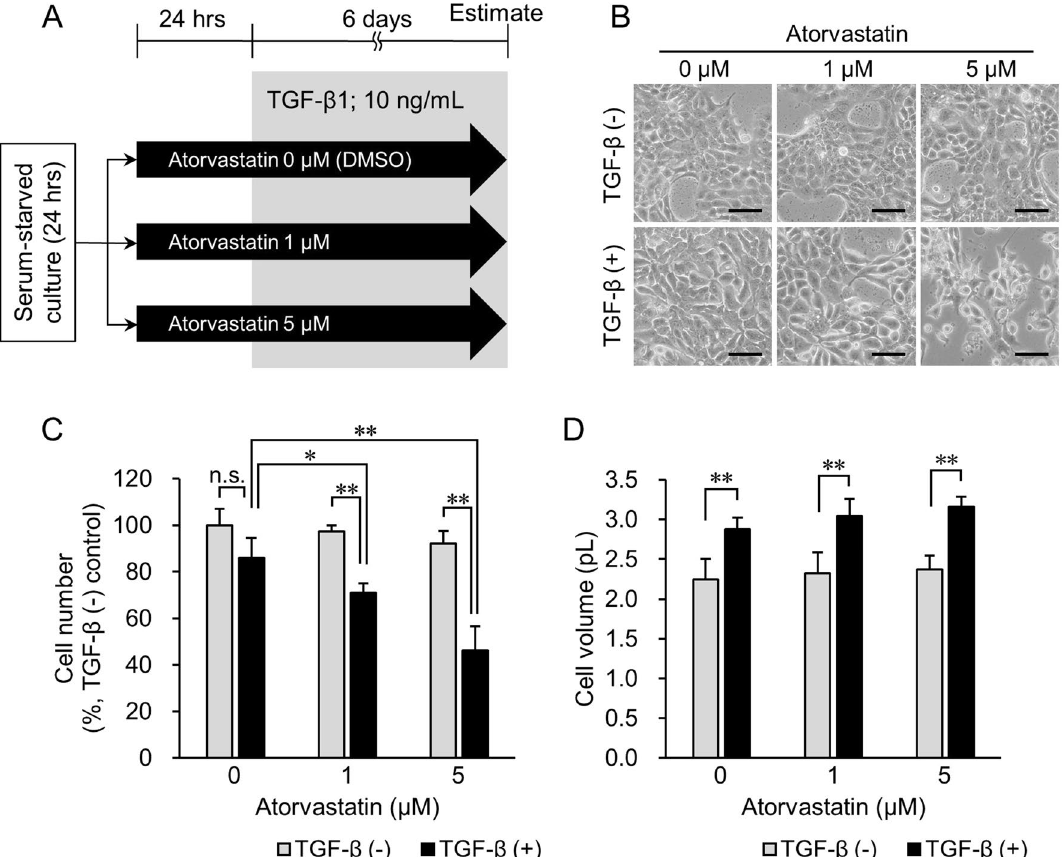
Figure 3. Effect of pretreatment with atorvastatin on cell number and cell volume in the TGF-β1 (−) and TGF-β1 (+) groups. ( A ) Overview of experimental procedures. The group treated with TGF-β1 in the presence of atorvastatin is designated as TGF-β (+) group. Cells treated with PBS are designated as TGF-β (−) group. DMSO-treated cells are used as no-drug treatment controls. ( B ) Phase-contrast imaging of cells treated with 0–5 μM atorvastatin after inducing TGF-β1 signaling. In the TGF-β (−) group (top panel), no significant difference in cell morphology is observed regardless of treatment with atorvastatin. In the TGF-β (+) group (bottom panel), cell number decreased in an atorvastatin dose-dependent manner. Additionally, the cytoplasmic volume of TGF-β (+) cells increased more than that in TGF-β (−) cells. Scale bar = 100 μm. ( C ) Cell number in the TGF-β (−) group and TGF-β (+) group treated with 0–5 μM atorvastatin. Value in TGF-β (−) control cells (atorvastatin 0 μM) is set as 100%. ( D ) Cell volume in the TGF-β (−) group and TGF-β (+) group treated with 0–5 μM atorvastatin. Each value represents mean ± SD (n = 3). Measurement values for each group are compared using the Bonferroni-Dunn post-hoc test. * p < 0.05, ** p < 0.01, n.s. not